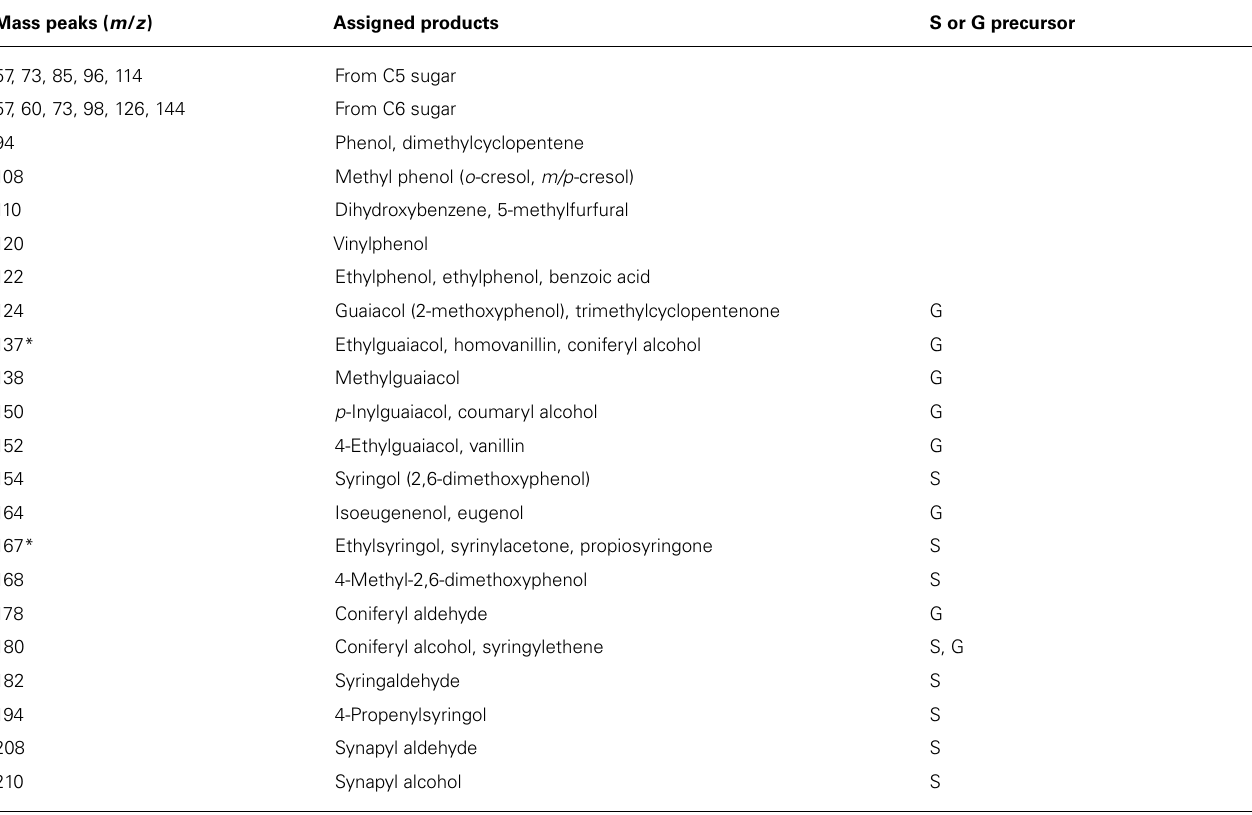
Table 1 | Peak assignments associated with Py-mbms spectrum for Populus wood based on literature (Evans and Milne, 1987; Sykes etal., 2008). Mass peaks ( m / z